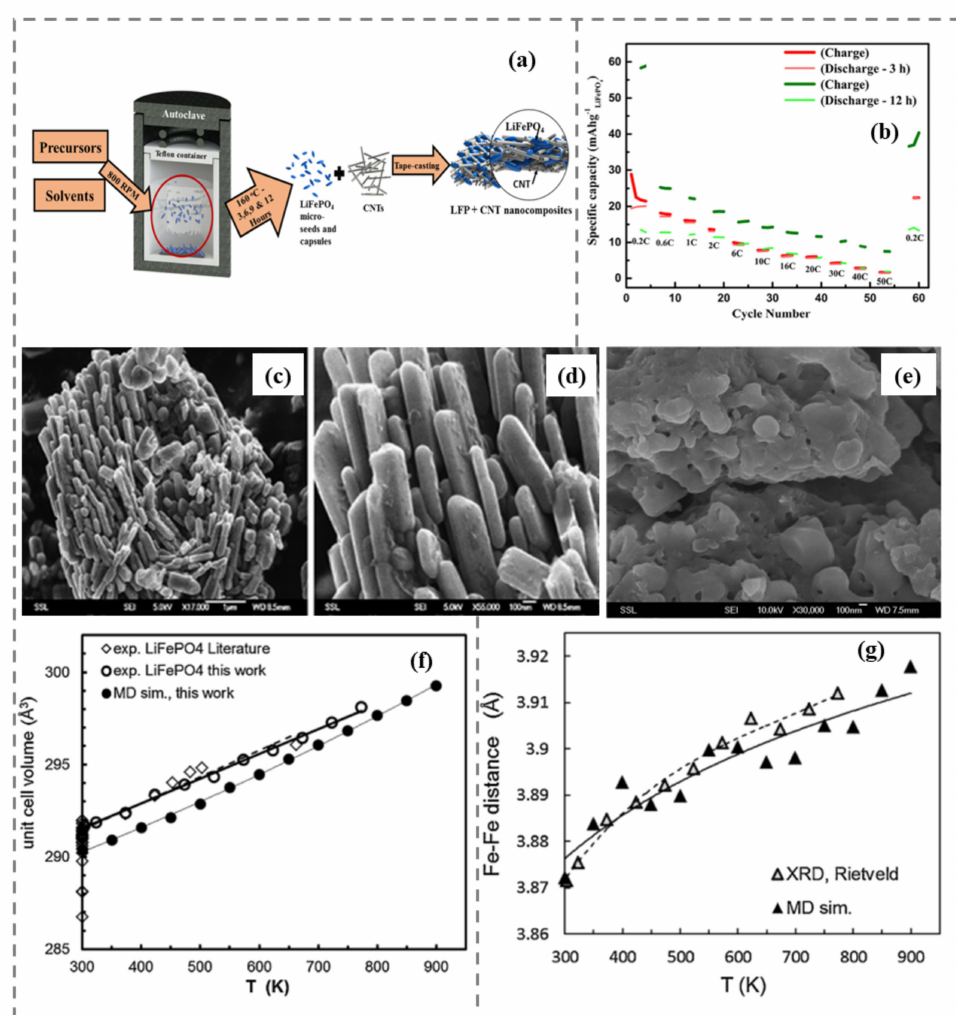
Figure 2. ( a ) Illustration of the hydrothermal route for preparing CNT/LFP ( b ) Half-cell studies using CNT/LFP cathodes (adapted with permission from Ref. [39]. 2018 Springer). ( c – e ) FESEM images of C-LFP nanoplates (adapted with permission from Ref. [40]. 2009, Ref. [41]. 2015 Elsevier). ( f ) Comparison of LFP volume variation using MD simulation ( g ) Fe-Fe distance variation in LFP simulated using MD. (adapted with permission from Ref. [41]. 2015